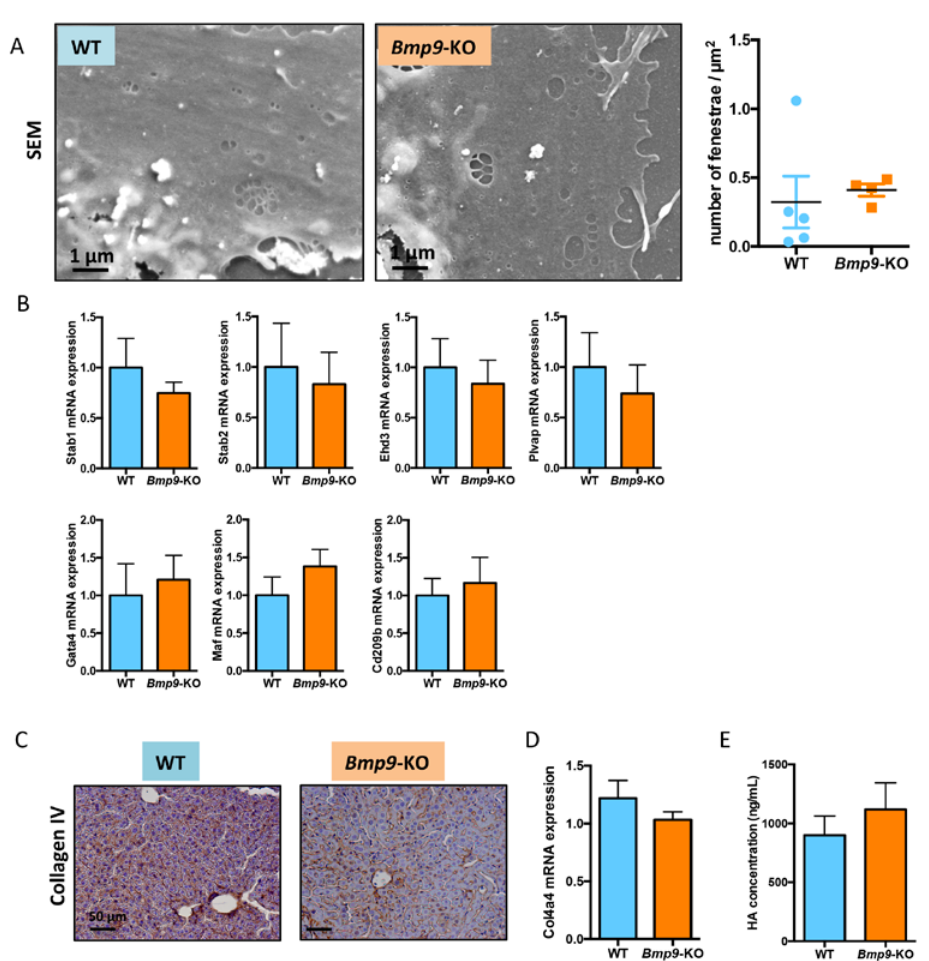
Figure 3. Liver sinusoidal endothelial cells (LSEC) capillarization in WT and Bmp9 -KO mice in the C57BL/6 genetic background. ( A ) Representative pictures of Scanning Electron Microscopy (SEM) on